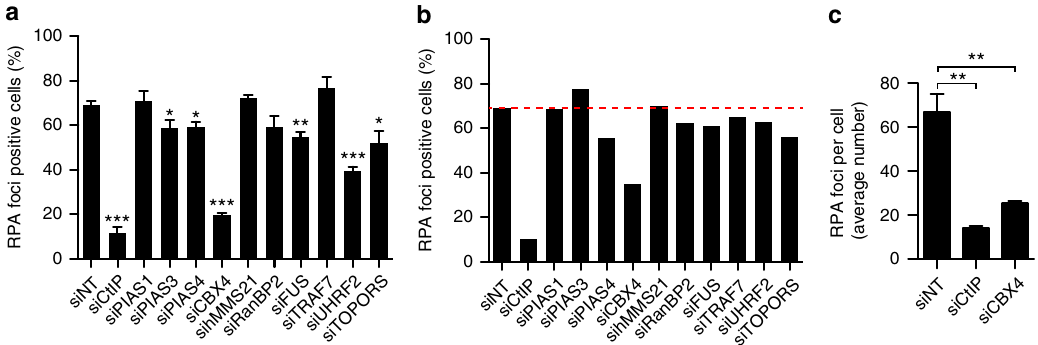
Fig. 1 CBX4 is involved in DNA resection. a DNA resection pro fi ciency measured as the percentage of RPA foci-positive cells upon exposing them to ionizing radiation (10 Gy). The average and SEM of three independent experiments are shown. Signi fi cance was determined by Student ’ s t -test comparing each condition to siNT cells. * P < 0.05; ** P < 0.01; *** P < 0.001. b Data represented in a , but normalized to cell cycle distribution (Supplementary Fig. 1d). Only S/G2 cells were used for normalization, with the S/G2 population of siNT cells considered as 1. c Average number of RPA foci per cell.